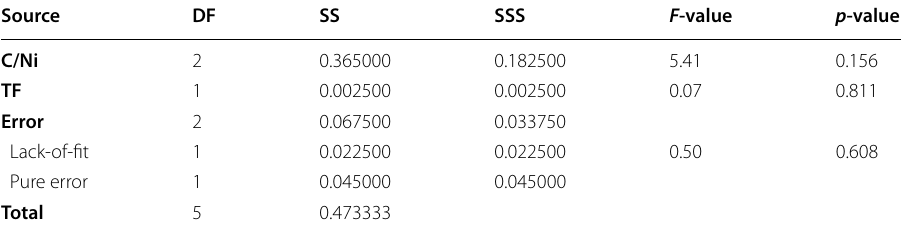
Table 5 ANOVA test associated with C/Ni and TF effects on pH Source DF